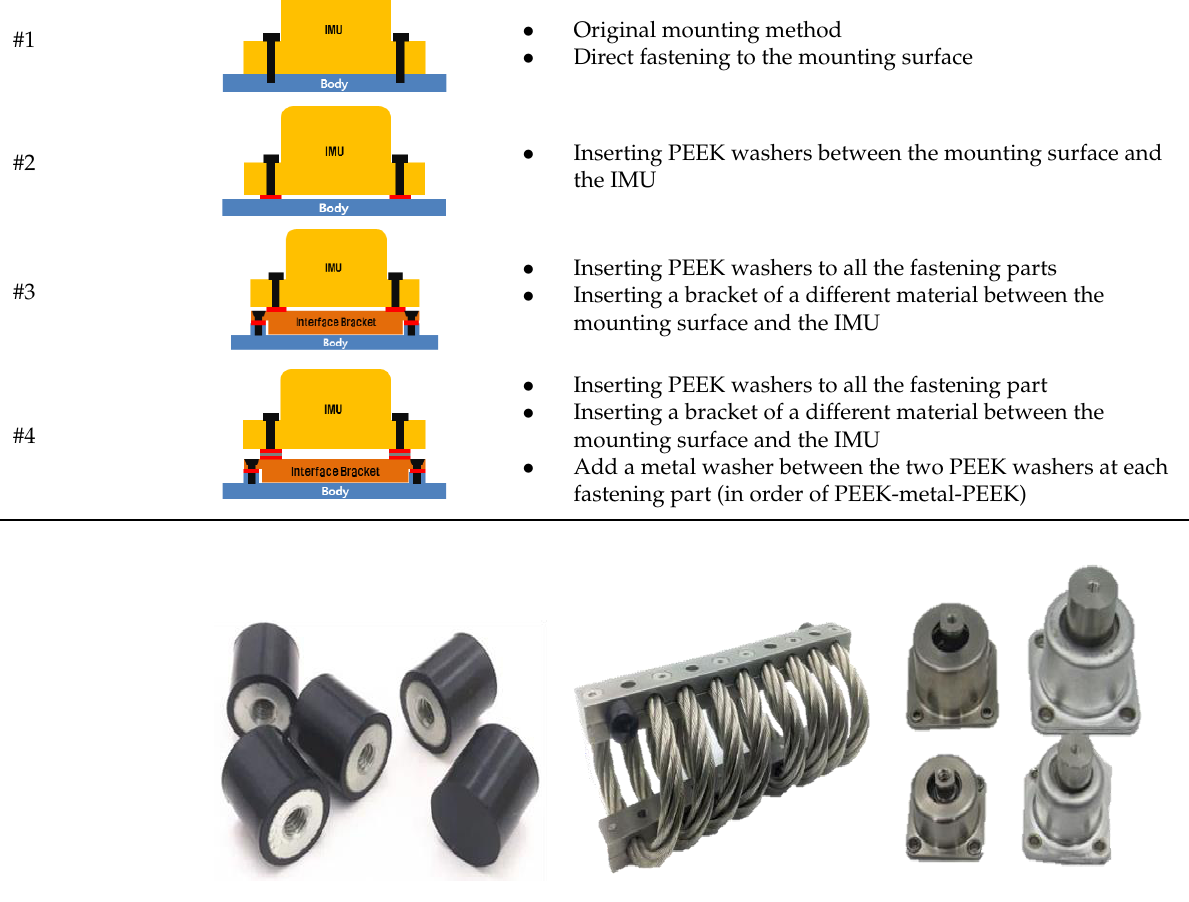
Table 2. Specification of pyro-shock